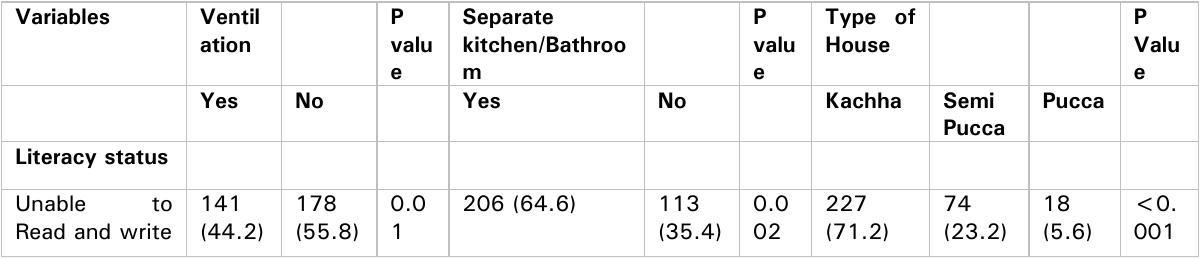
Table.3. Housing condition as observed in the community (N=